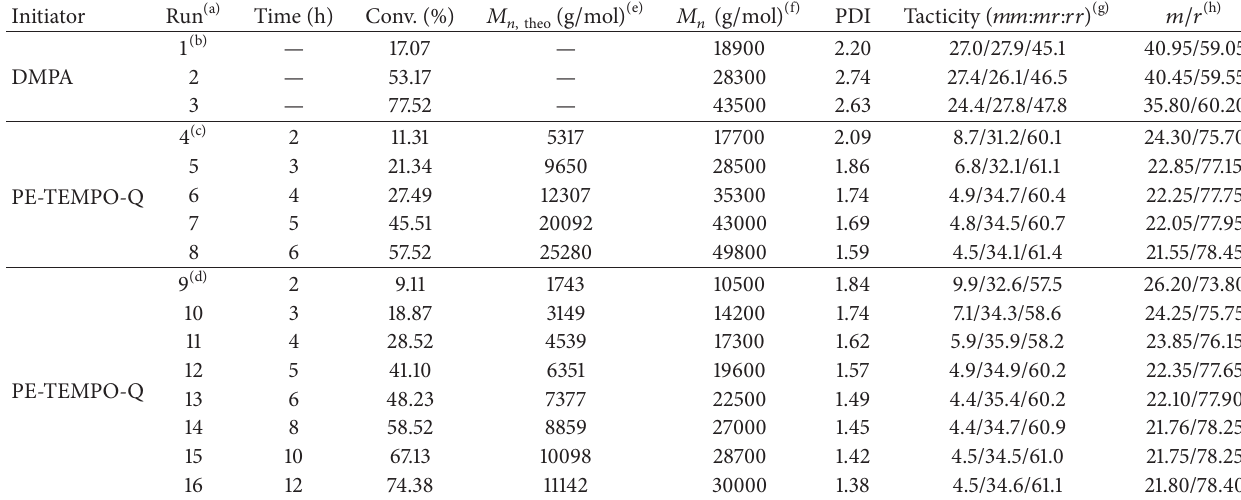
Table 1: Experiment data of PMMA by photopolymerization.